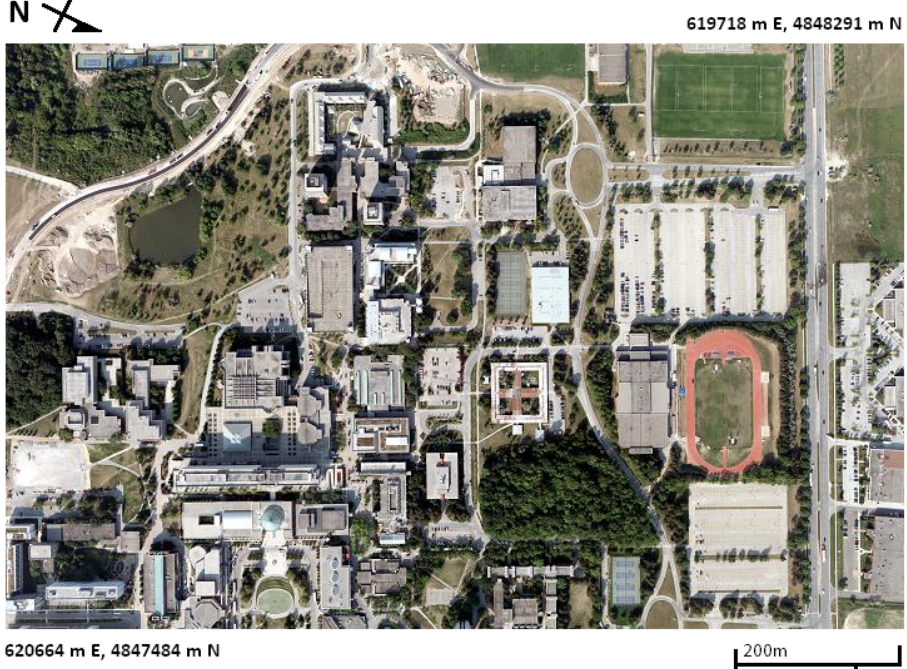
Figure 1. True colour high spatial resolution image of York University, Toronto, Ontario,